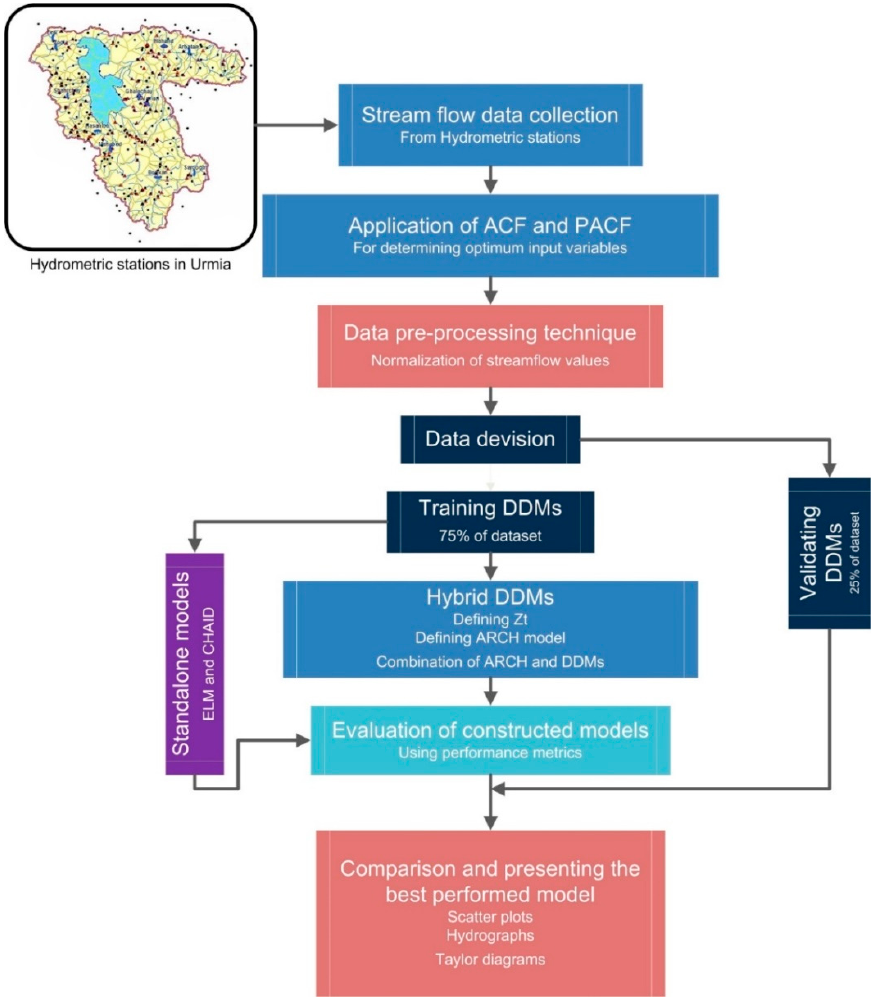
Figure 3. Schematic structure of the hybrid (OPELM/CHAID-ARCH) models integrating the autoregressive conditional heteroskedasticity (ARCH) time-series approach with standalone extreme learning machine (OPELM) and Chi-square automatic interaction detector (CHAID) models.